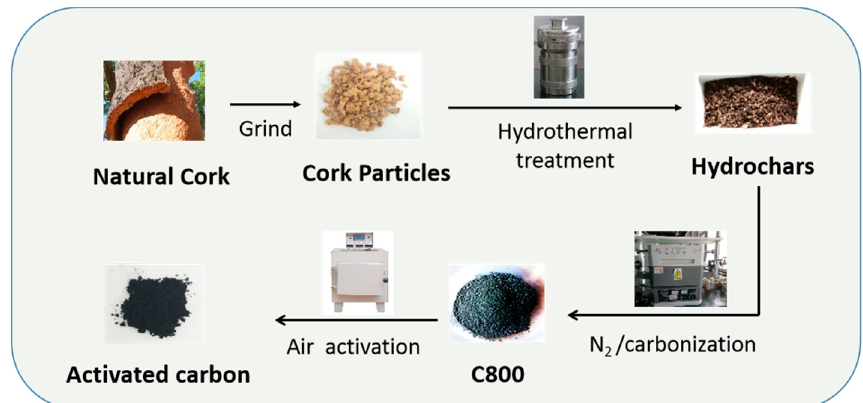
Figure 1. Schematic illustration for preparing functional carbon materials.